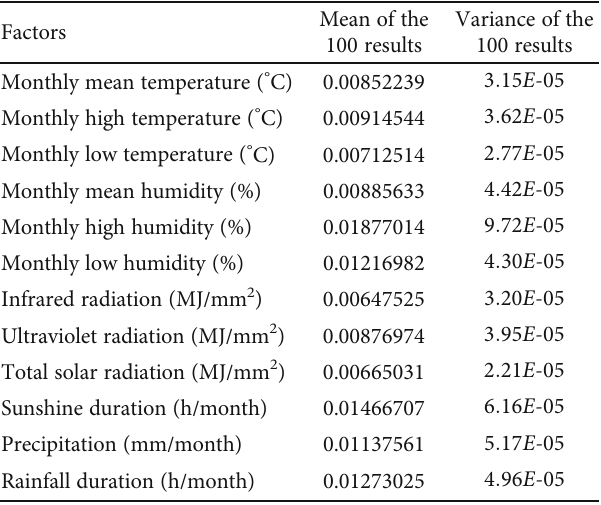
Table 6: Mean and variance of the importance of the climatic factors after 100 repetitions of the calculations.